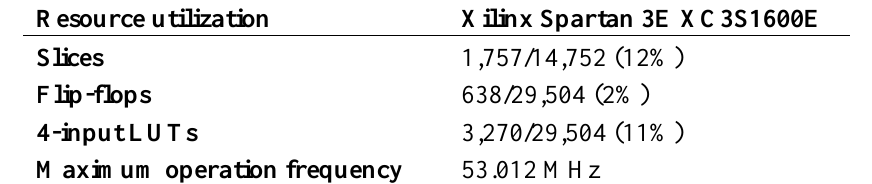
Table 1. Resource usage of the